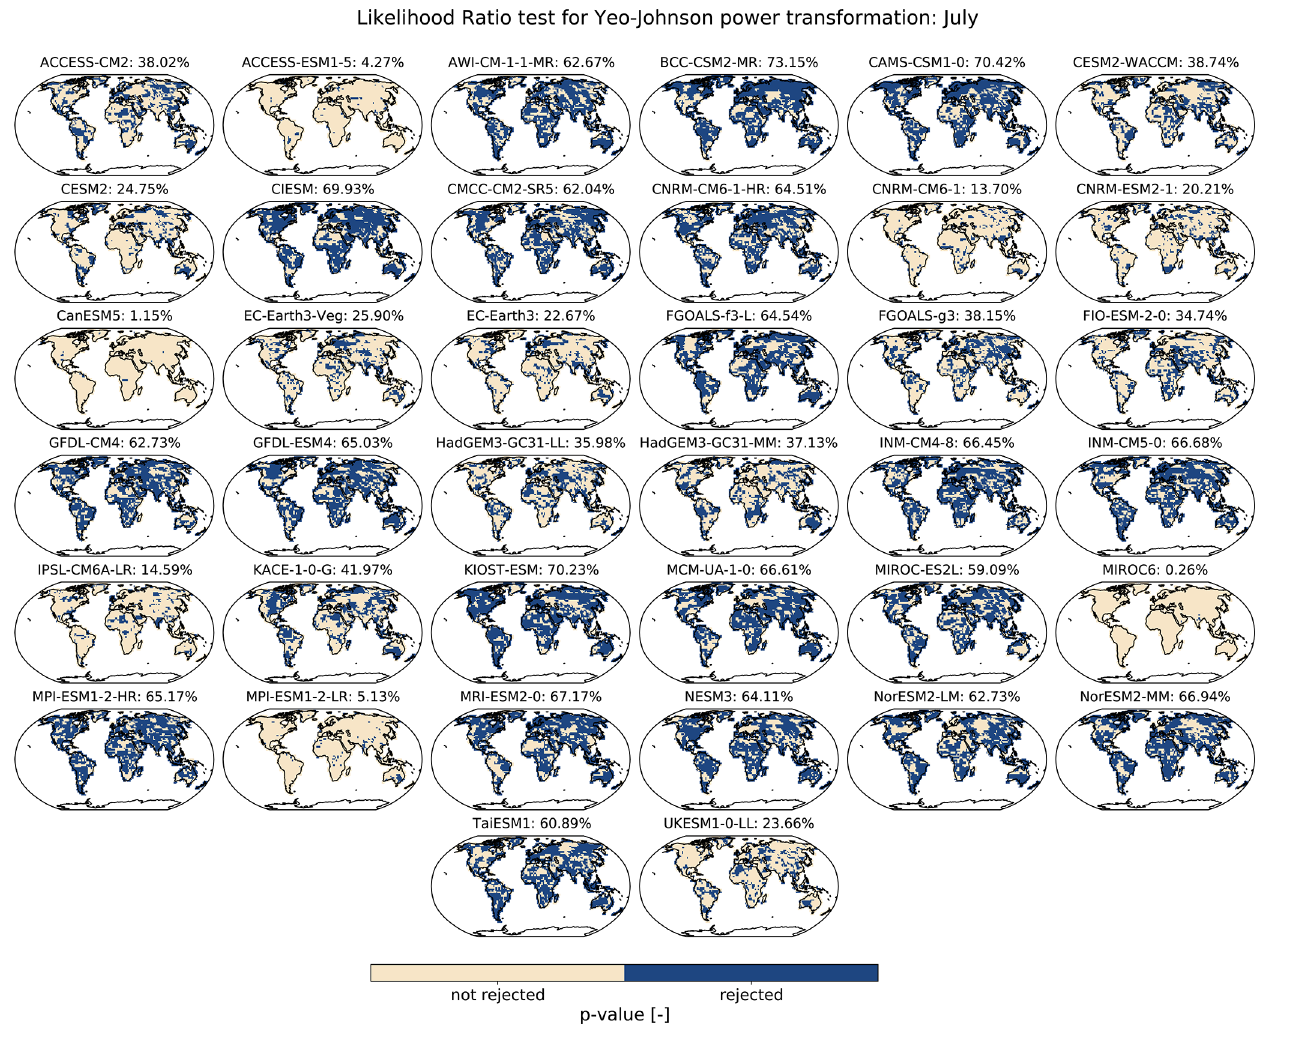
Figure C2. Same as Fig. C1, except for July.